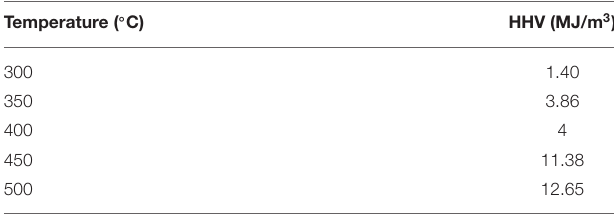
TABLE 4 | The higher heating value of the gas from pretreated ASR pyrolysis process as a function of temperature.